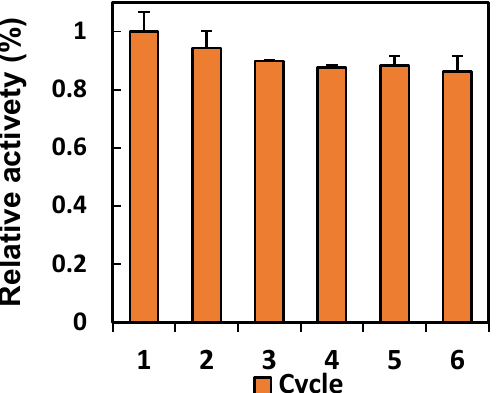
9 of 12 Figure 5. The synthesis of acetoin from ethanol with the immobilized cascade enzymes. 3.5. The Reusability of Immobilized Cascade Enzymes The economics of industrial and continuous production are related to the reusability of the biocatalysts. Thus, the reusability of the immobilized cascade enzymes was ex-